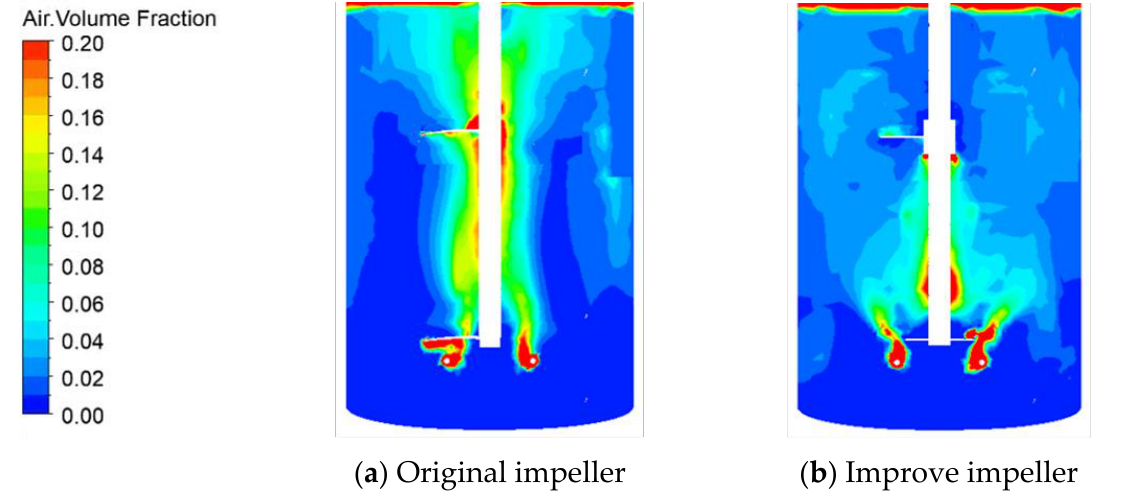
Figure 7. The value of solid volume frame of different impeller types under 125 rpm.